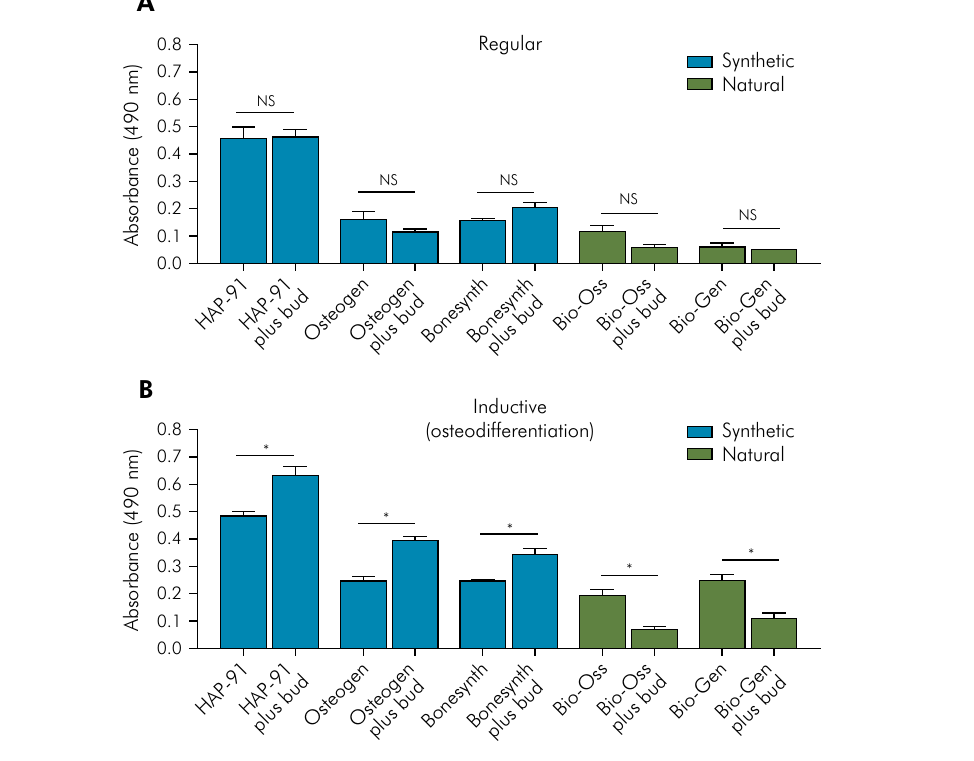
Figure 7. Bar graphs comparing the mineralization potential of each HA conditioned media after the addition of 0.5% v/v budesonide in regular (a) and inductive (b)